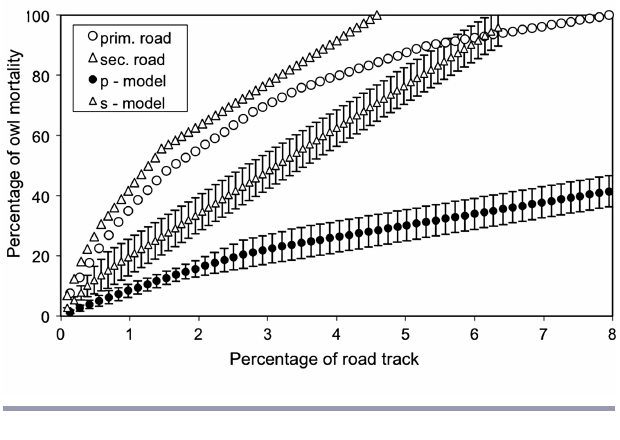
Fig. 11 . Relationship between the fraction of road that is responsible for all owl mortality on primary roads and secondary roads. Also presented are the modeled relationships on the basis of random distribution of all deceased owls (+/- SD). Because there is significant deviance between the observed and modeled outcomes (1.645 x SD), we conclude that on both primary roads and secondary roads clustering of road casualties occurs.